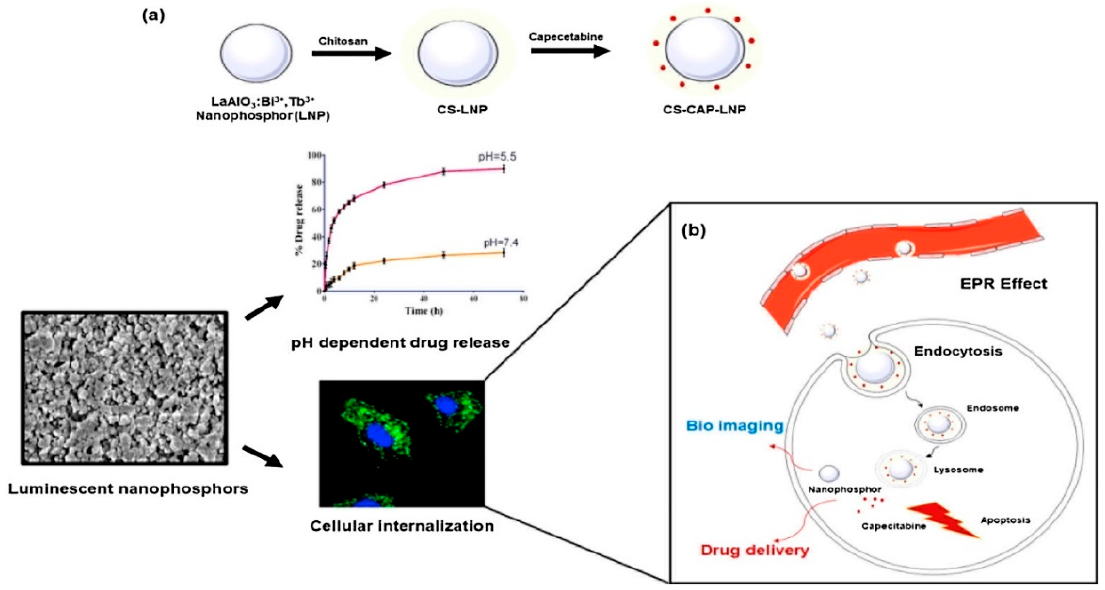
Figure 18. ( a ) Synthesis of CS-CAP-LNP. ( b ) Accumulation of CS-CAP-LNP at the tumor site due to the EPR effect and internalization of CS-CAP-LNP in tumor cells (Reprinted with permission from [70]).